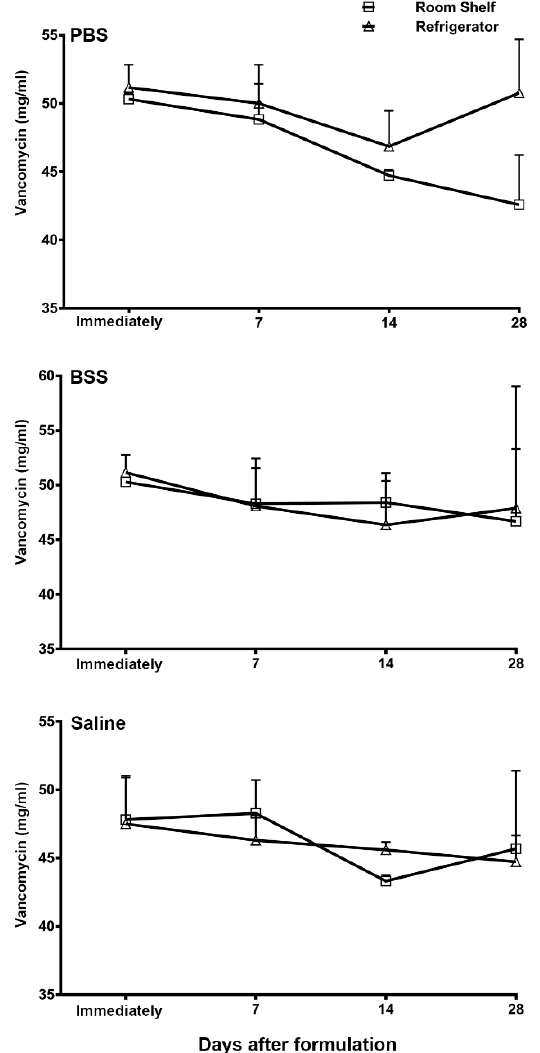
Figure 1. Quantification of vancomycin (mg/mL) in the phosphate-buffered saline (PBS), balances salt solution (BSS), and normal saline formulations analyzed by high-performance liquid chromatography (HPLC) immediately after formulation and then at days 7, 14, and 28 after storage at room temperature or under refrigeration. The data is presented as mean ± standard error of mean